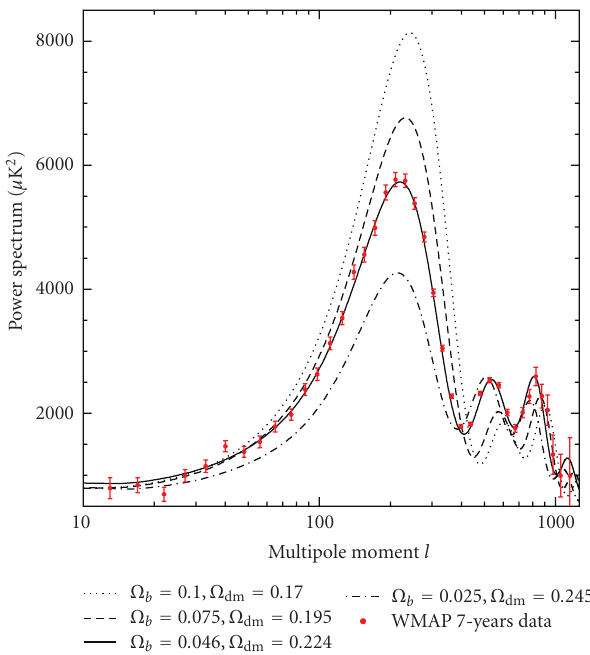
Figure 3: The CMB Anisotropy Power Spectrum for various values of Ω b and Ω dm (holding Ω tot = 1) with WMAP year 7 data. The anisotropy power spectrum gives the level of temperature fluctuations on patches of various angular scales, where a spherical version of a Fourier transform gives multipoles l , where roughly l = 180 ◦ /θ , with θ the angular scale in